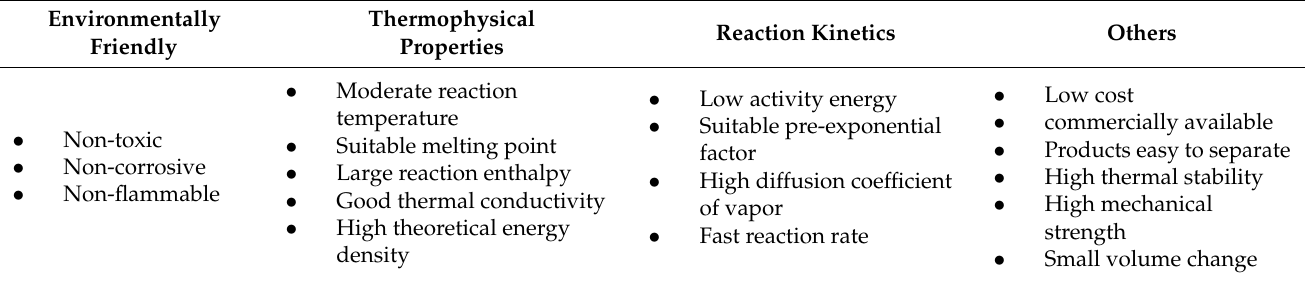
Selection criteria for salt hydrates adsorption-based TCES for space heating applications